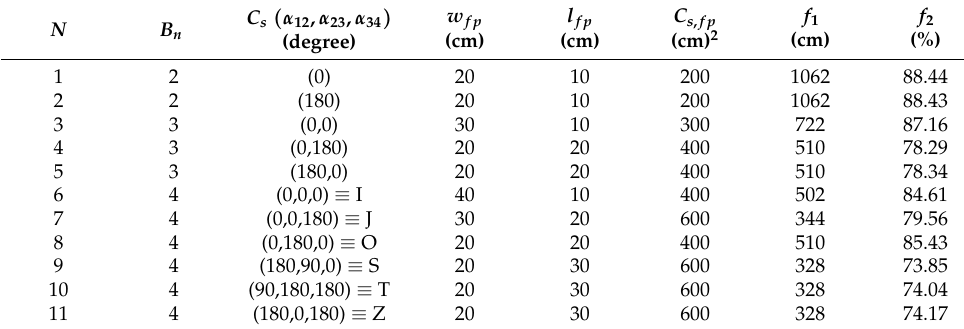
Table 5. Standard polyomino morphologies in environment-1.